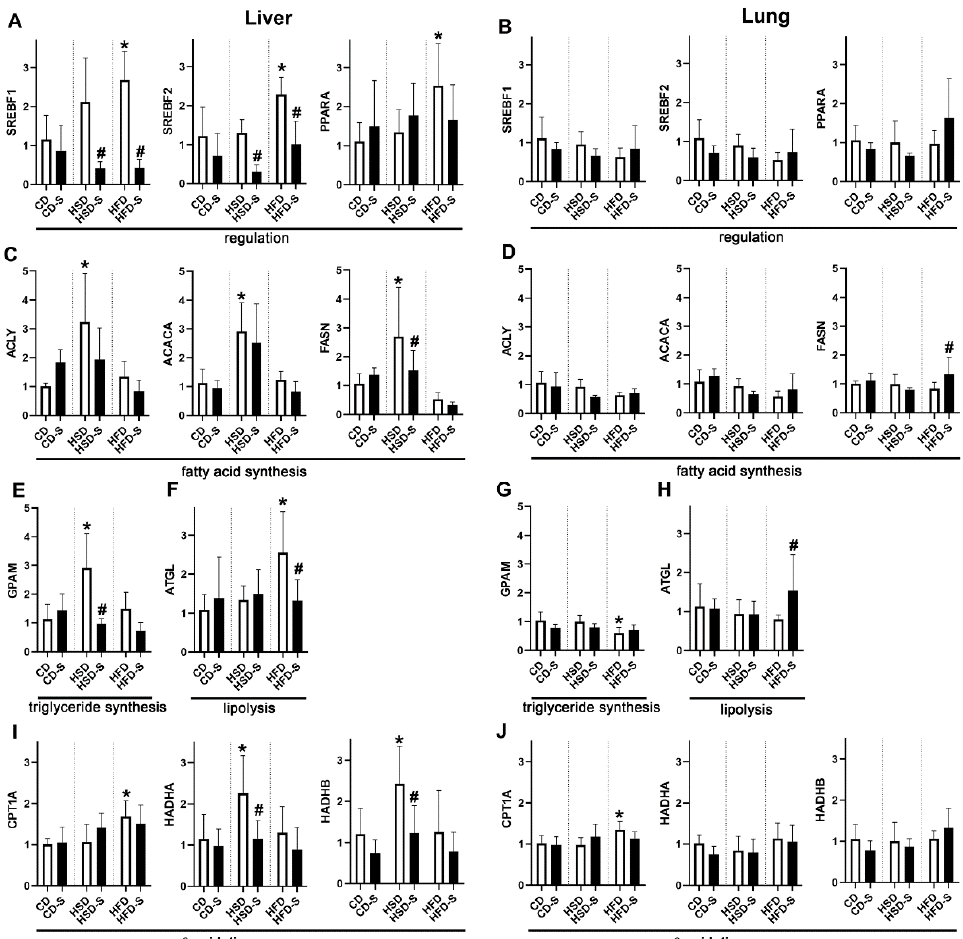
Figure 5. Effects of diets and spermidine on hepatic and pulmonary expression profiles of lipid metabolism-related proteins. ( A , B ) Sterol regulatory element binding transcription factors 1 and 2; peroxisome proliferator-activated receptor α . ( C , D ) ATP citrate lyase; acetyl-CoA carboxylase α ; fatty acid synthase. ( E , G ) Glycerol-3-phosphate acyltransferase. ( F , H ) Adipose triglyceride lipase. ( I , J ) Carnitine palmitoyltransferase 1 α ; mitochondrial trifunctional protein, subunits α and β . Shown are fold expression values given as group means ± SD; n = 5 for every group. Data were compared by 2W-ANOVA followed by Tukey test; p -values < 0.05 are indicated by * for significant difference compared to CD (dietary effect) or # for significant difference compared to respective non-supplemented diet group (spermidine effect). CD, control diet; HSD, high sucrose diet; HFD, high fat diet; -S,